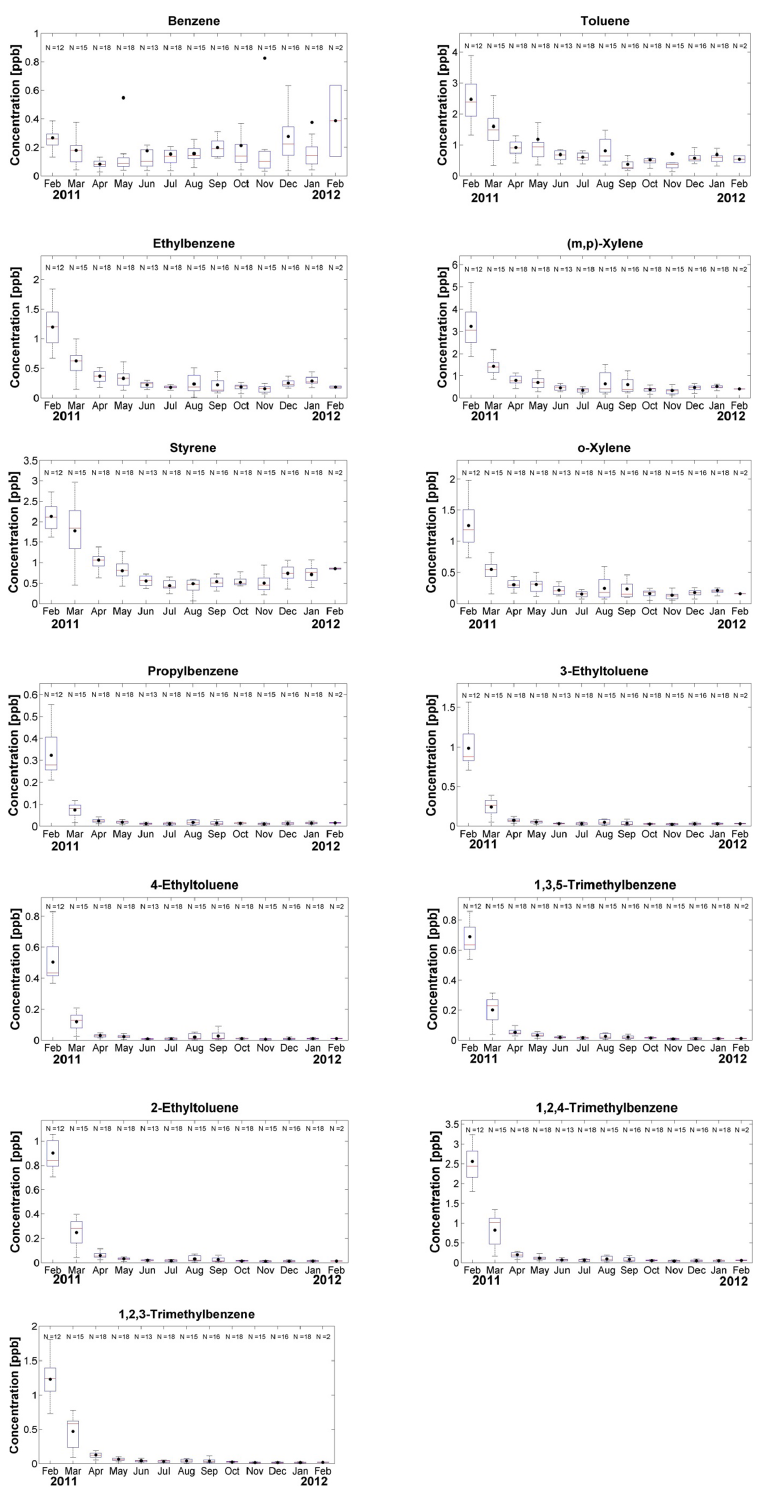
Figure 2. Monthly annual variation in aromatic hydrocarbon concentrations measured during the 1-year sampling period. The red line of each box indicates the median (50th percentile), the black dot the mean, the top and bottom edges of the box the 25th and 75th percentiles, and the whiskers ± 2.7 σ or 99.3% coverage if the data have a normal distribution (MATLAB, 2010). The values displayed near the top of the graphs indicate the number of samples ( N ) analysed for each